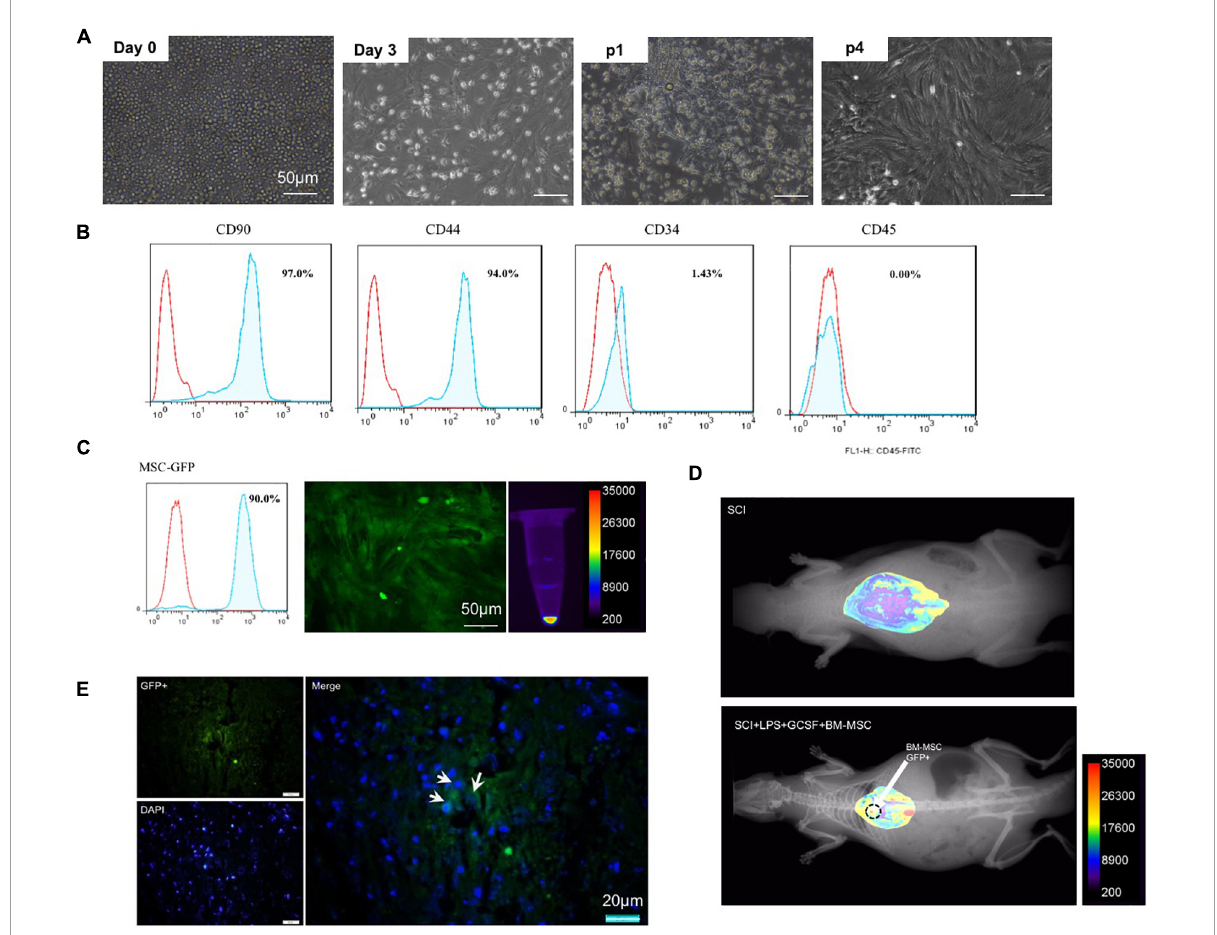
FIGURE6 Characterization of BMSC. (A) Bright field microscopic of cells at P0–P4 after cultivation. (B) Flow cytometry analysis for P4 MSC. (C) GFP-positive implanted cell. (D,E) Homing of engraftment GFP + MSC detected in the lesion site at 7